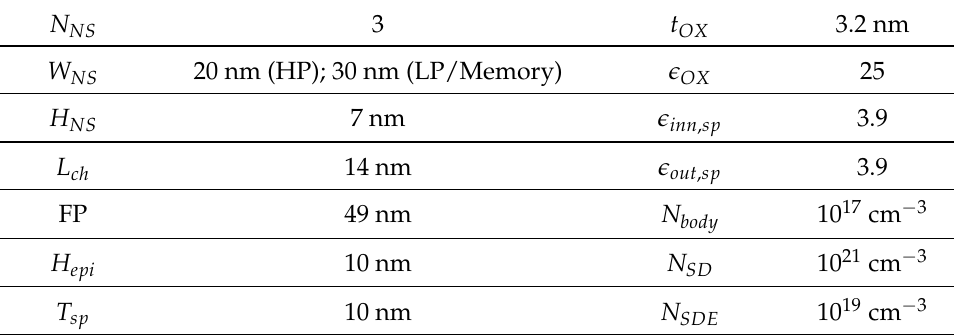
Table 1. Geometrical and physical parameters for the simulated n-type NS-GAAFET.